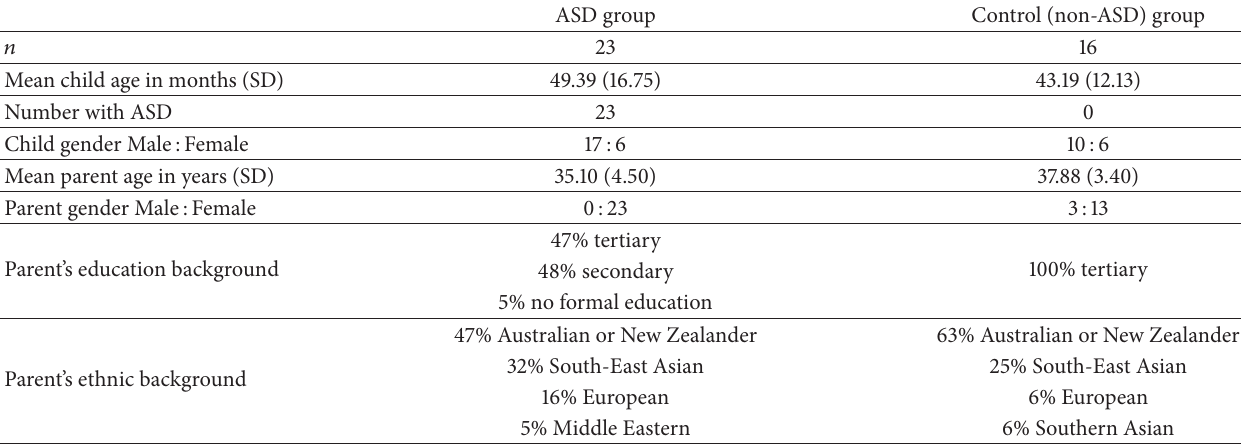
Table 2: Demographic information for the ASD and control